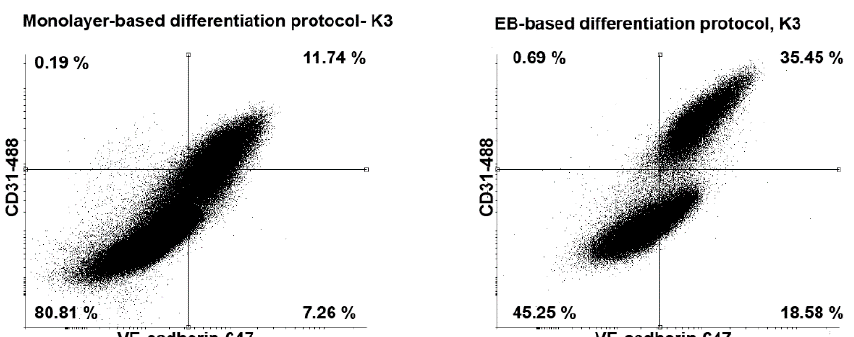
Figure 3. Flow cytometry analysis of CD31 and vascular endothelial cadherin (VE-cadherin) ex- pression of endothelial cells (ECs) derived from different human induced pluripotent stem cells lines. ECs differentiated with embryoid body based protocol express higher level of VE-cadherin and CD31.